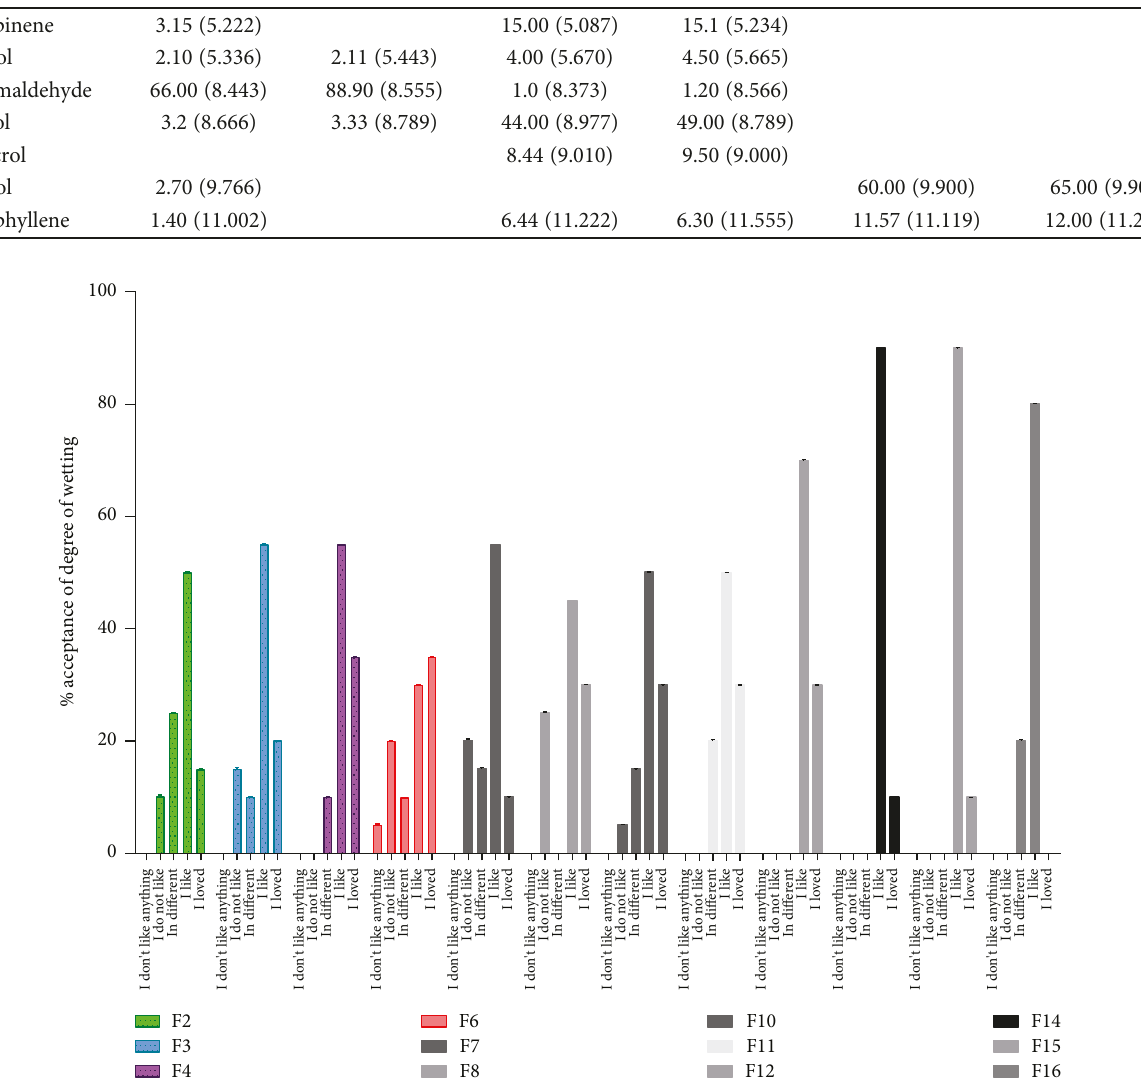
Figure 10: Acceptance percentage of the degree of wetting by panelists for di ff erent